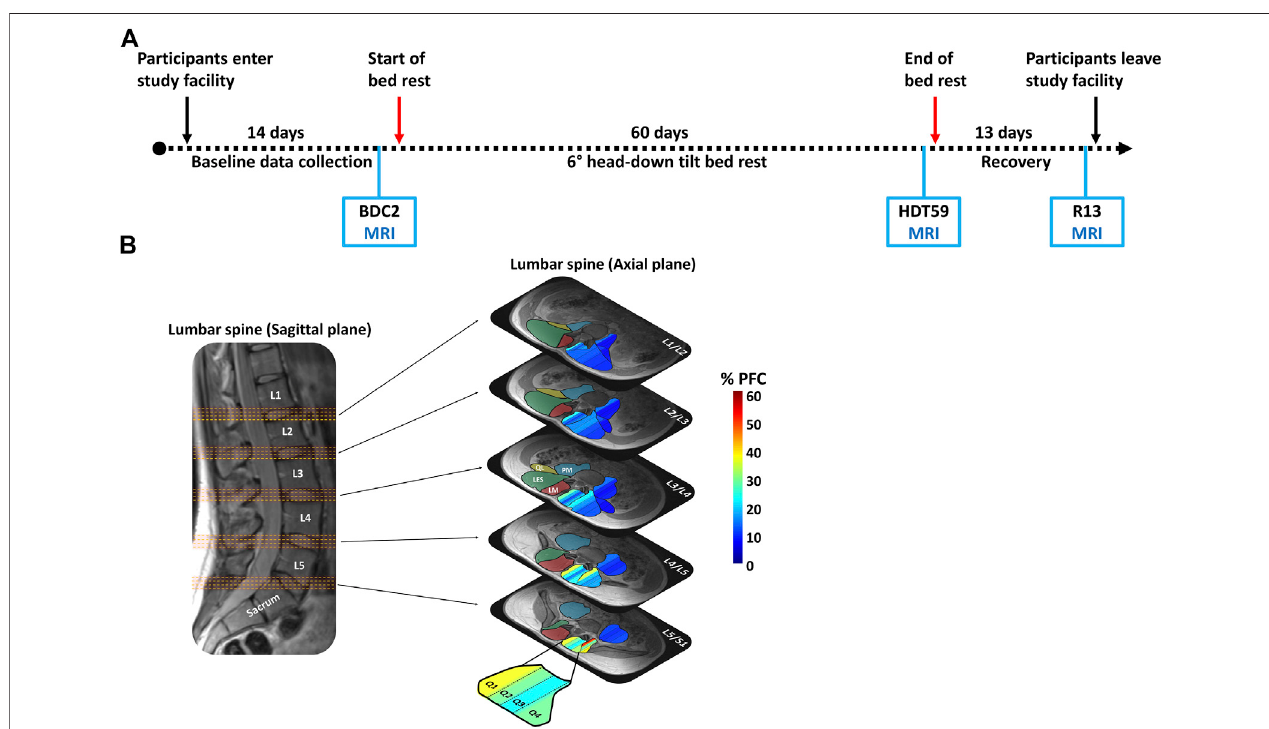
FIGURE 1 | (A) Time schedule of each of the two campaigns. Magnetic resonance imaging was collected 2 days before the beginning of the bed rest period (BDC2),day59ofthehead-downtiltbed rest(HDT59),andday13oftherecoveryperiod (R13). (B) Fivegroupsoffouraxialsliceswereidenti fi edfromthesagittalimage for each of fi ve lumbar intervertebral disc levels (L1/L2, L2/L3, L3/L4, L4/L5, L5/S1) to obtain the images used for measurement. The muscle volume of the lumbar multi fi dus(LM — red shaded area), lumbarerector spinae (LES — green shaded area), quadratus lumborum (QL — yellow shaded area),and psoas major (PM — blue shaded area)wascalculated.Paraspinalmusclefatcontent(PFC)wasautomaticallyquartiledfrommedialtolateralbasedonequalpixelnumbers(Q1,Q2,Q3,andQ4). The color scale represents the percentage of fat content (0% –